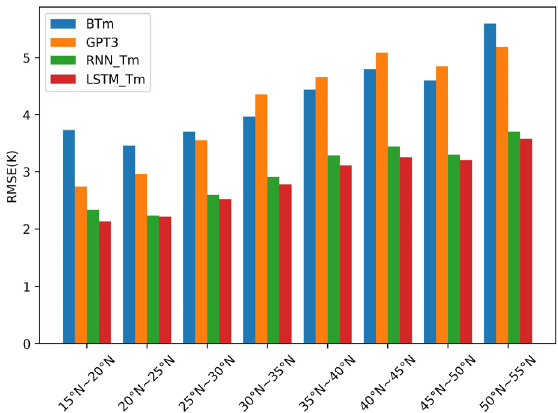
Figure 8. RMSE of various models in different latitude zones.